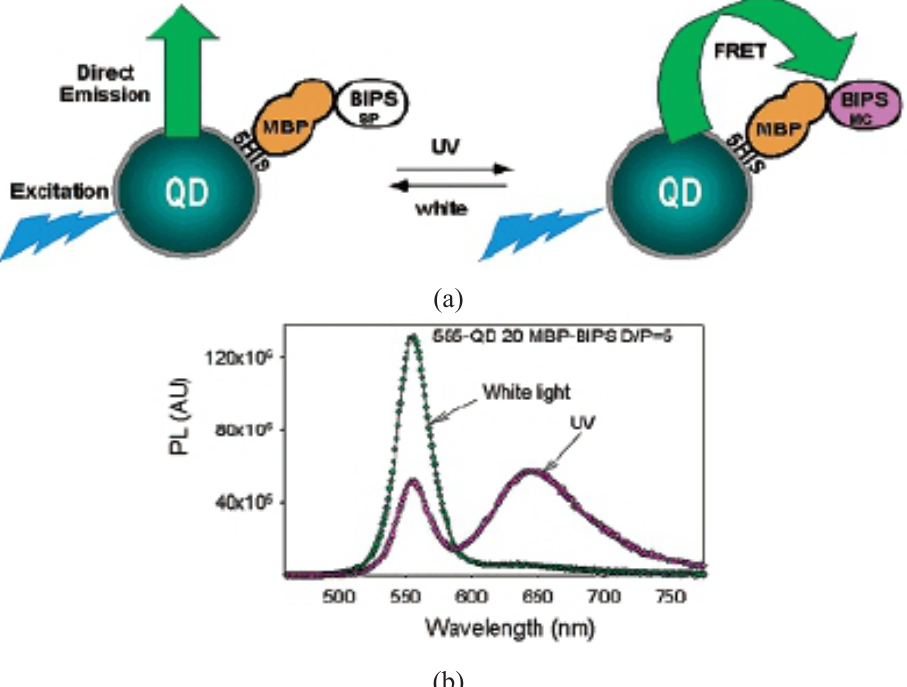
Figure 5. (a) Schematic of QD modulation by MBP-BIPS. (b) Spectral properties and modulation function of MBP-BIPS and the 555 nm emitting QDs. Reproduced from